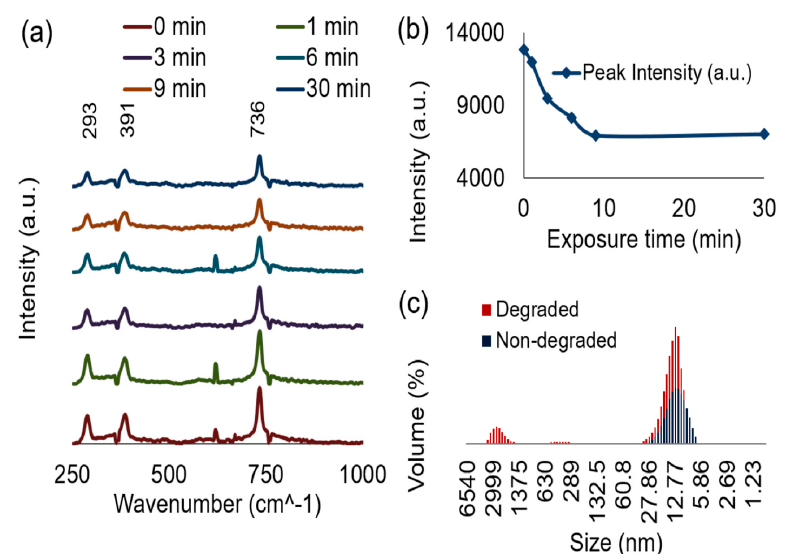
Figure 4. ( a ) Display of the Raman spectra of ferritin over a 30 min accelerated heat stress exposure time. ( b ) Shows the change in the intensity of the 736 cm − 1 peak taken from the Raman spectra as a function of the exposure time. ( c ) Showcases the size and size distribution of the denatured and non-denatured ferritin samples.